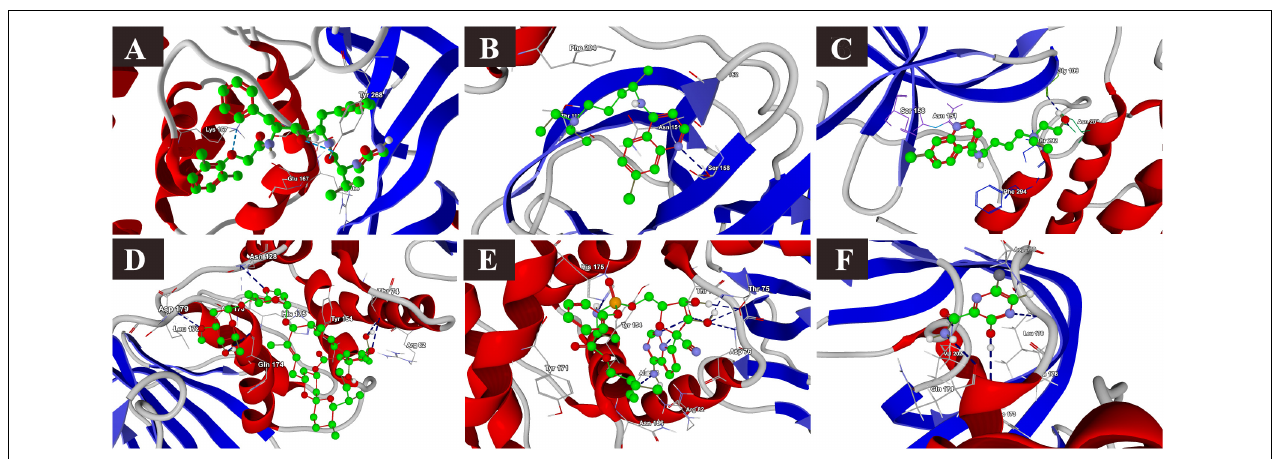
FIGURE 5 | Binding interactions of selected drugs with SARS-CoV-2 papain-like protease. (A) lopinavir, (B) chloroquine, (C) hydroxychloroquine, (D) ivermectin, (E) remdesivir, and (F) favipiravir. TABLE 4 | Docking of SARS-CoV-2 M and N proteins against different drugs. Drug Viral protein MolDock score Protein – ligand interactions